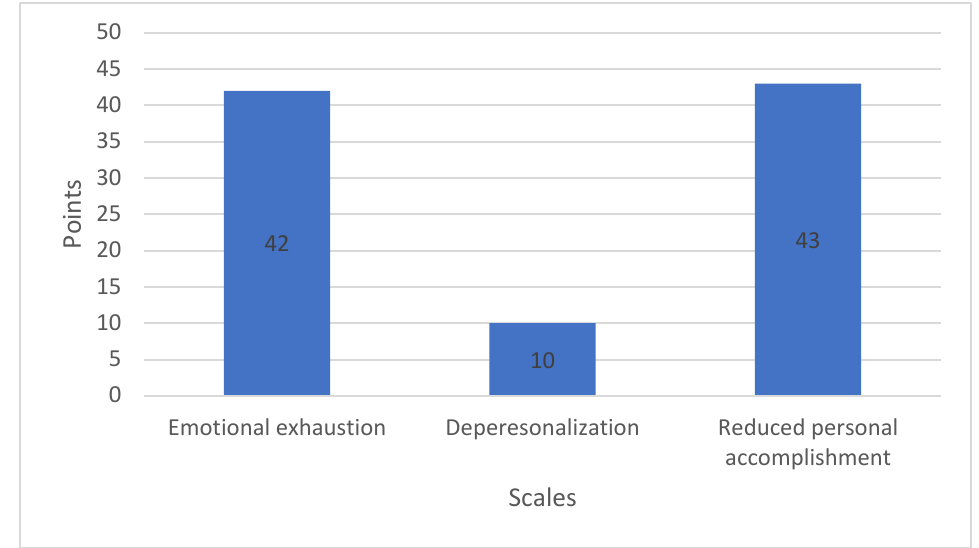
Figure 1. The indicators of respondents’ burnout (N = 195).